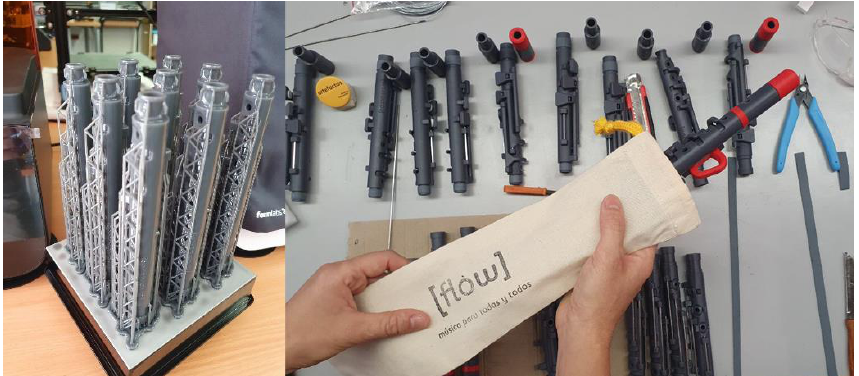
Figure 6. Manufacturing and assembly of Flow.